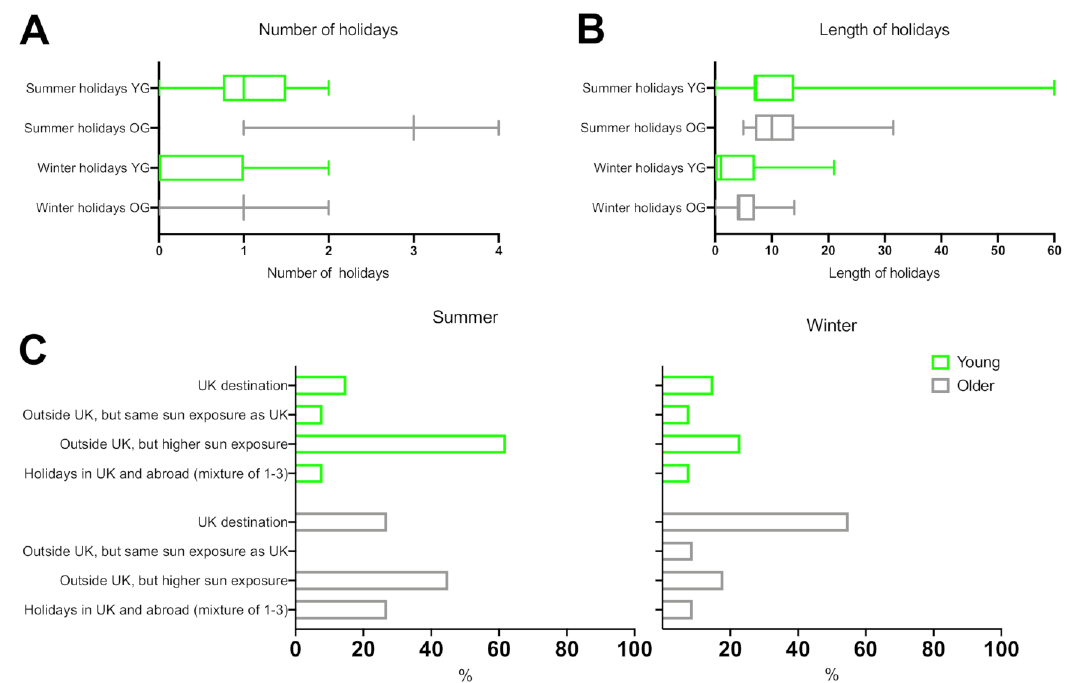
Figure 3. ( A ) Number of winter and summer holidays taken by younger (YG) and older groups (OG). ( B ) Length of winter and summer holidays in younger (YG) and older groups (OG). Plots A and B show range (whiskers), median (thick lines) and lower and upper quartiles (boxes) of number and length of winter and summer holidays. ( C ) Percentages of younger and older volunteers responses showing the type of holiday destination they take during summer and winter